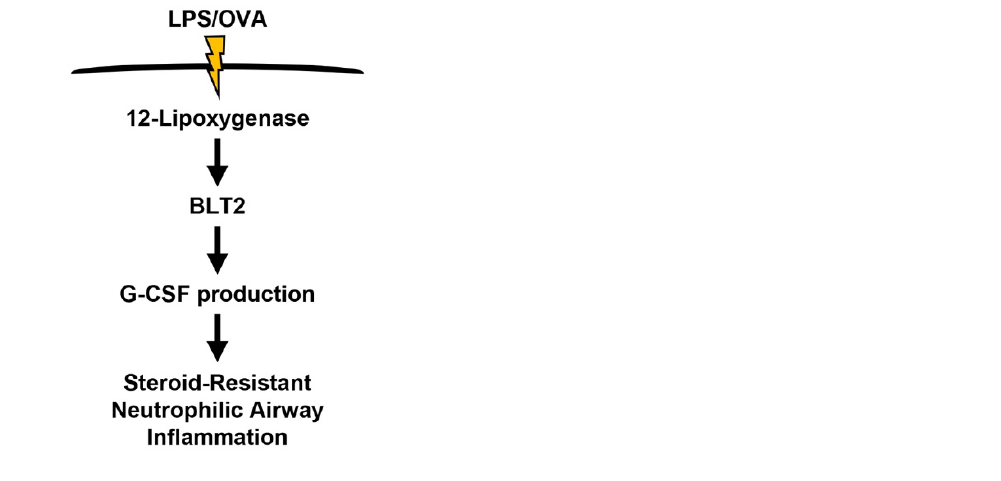
Figure 6. The proposed scheme of the 12-LO-BLT2-G-CSF cascade in LPS/OVA-induced steroid- resistant neutrophilic airway